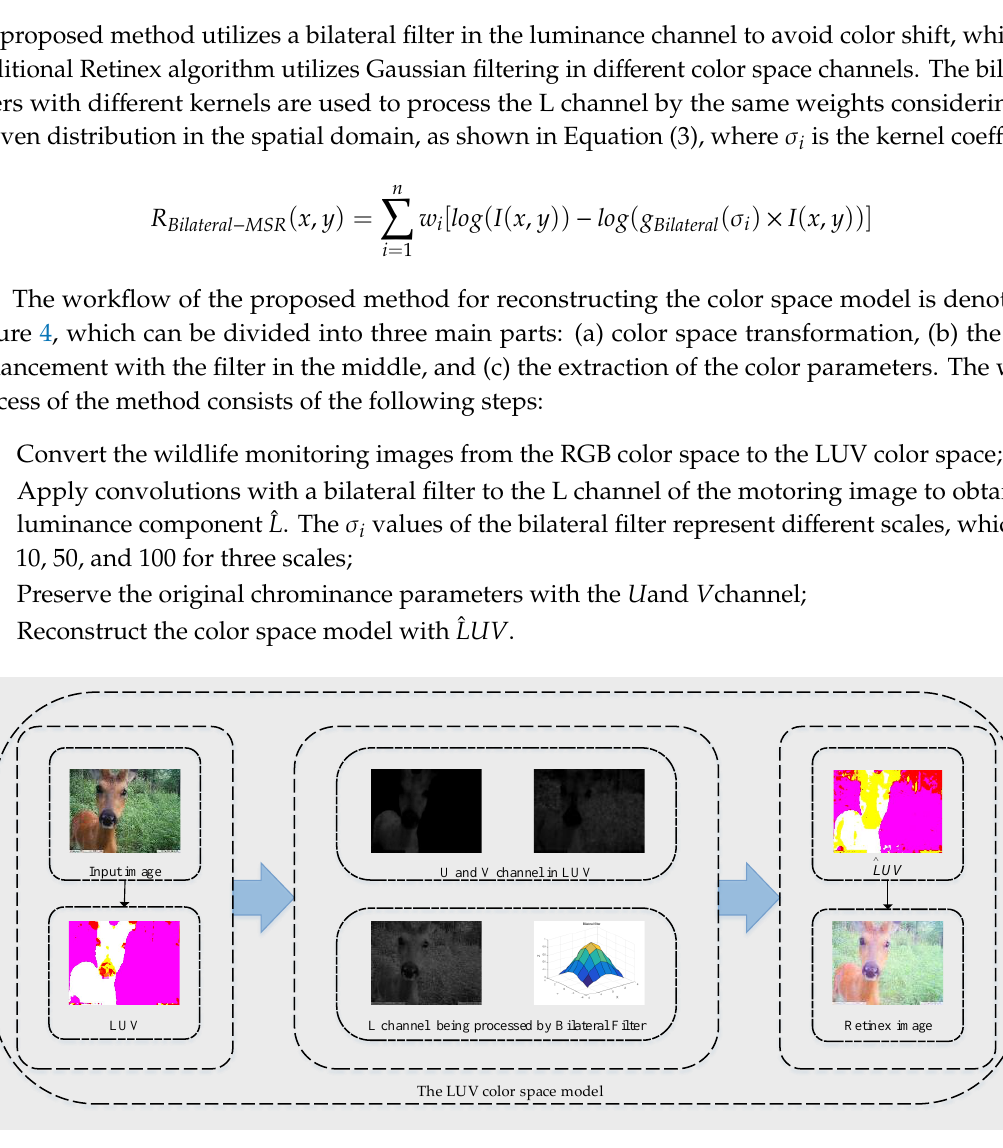
Figure 4. Flow-process diagram of the proposed method.